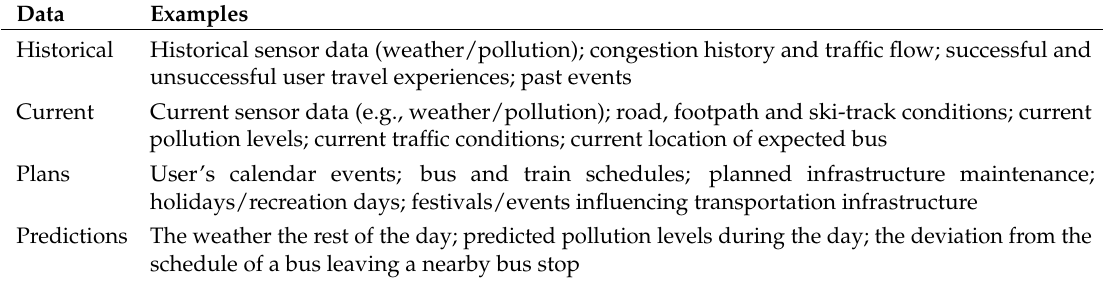
Table 3. Examples of historical data, current data, plans and predictions (from